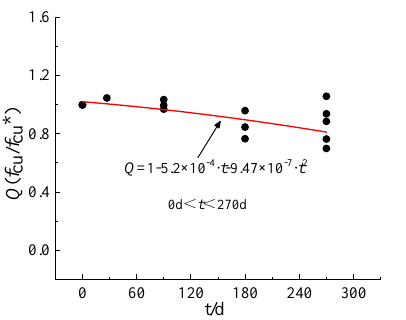
Figure 12. Fitting formula for concrete strength correction factor ( Q ).